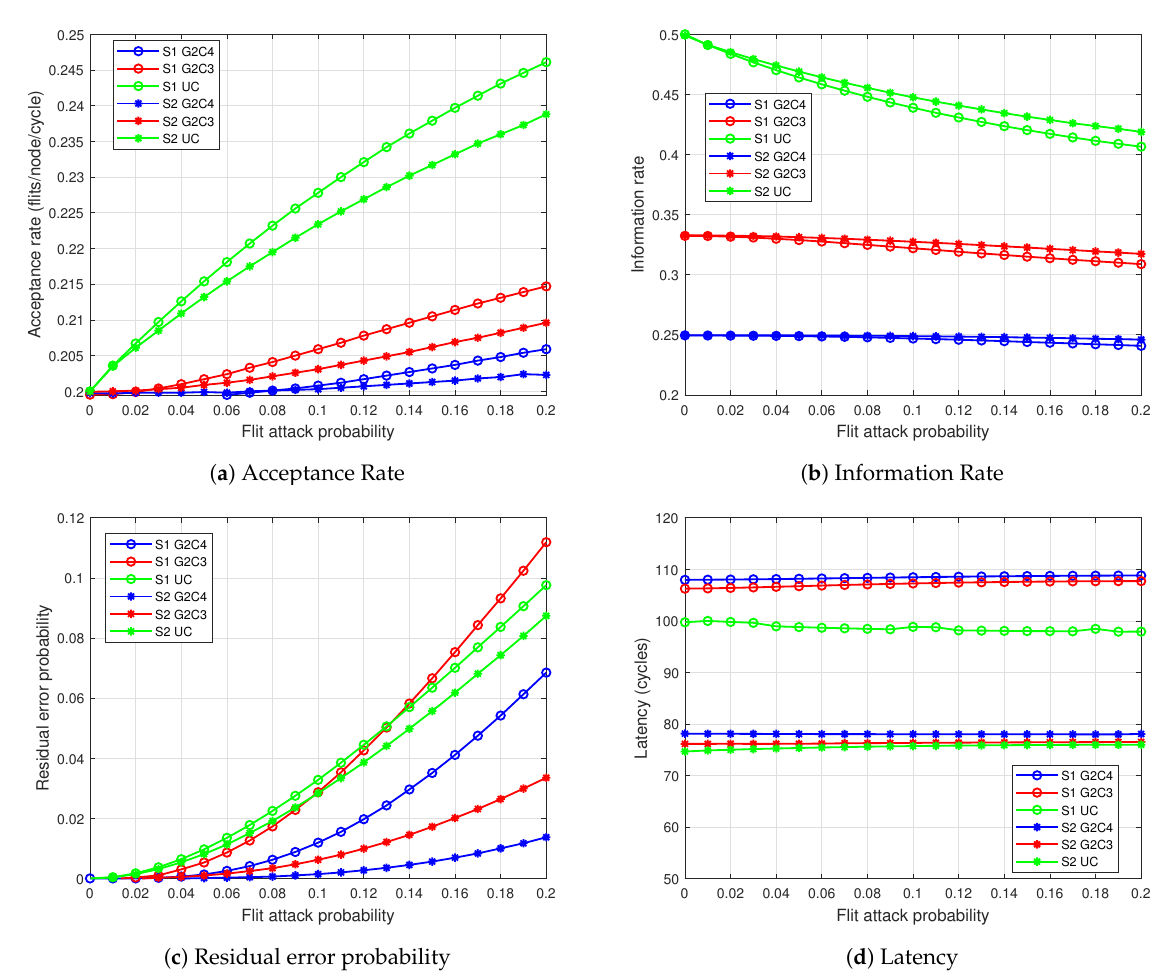
Figure 5. Simulation results for the base scenario: 8 × 8 2D mesh with 8 attacking routers. The residual error probability (Figure 5c) starts from 0 and increases with increasing attack probability, as fewer logical transmission units are received at the destination. In general, S1 has higher error probabilities, because of its higher attack susceptibility. For the greatest attack probability of p a = 0.2, the lowest error probability of ≈ 0.014% is achieved by S2/G2C4. The redundancy of the NC schemes displays its advantage over the UC schemes; however, from the curve of S1/G2C3, it can be observed that the redundancy of G2C3 is insufficient at higher error rates to counter the higher attack susceptibility so that the error performance of S1/G2C3 degrades rapidly and becomes worse than UC at attack probabilities p a = 0.1 and p a = 0.13 for S1 and S2